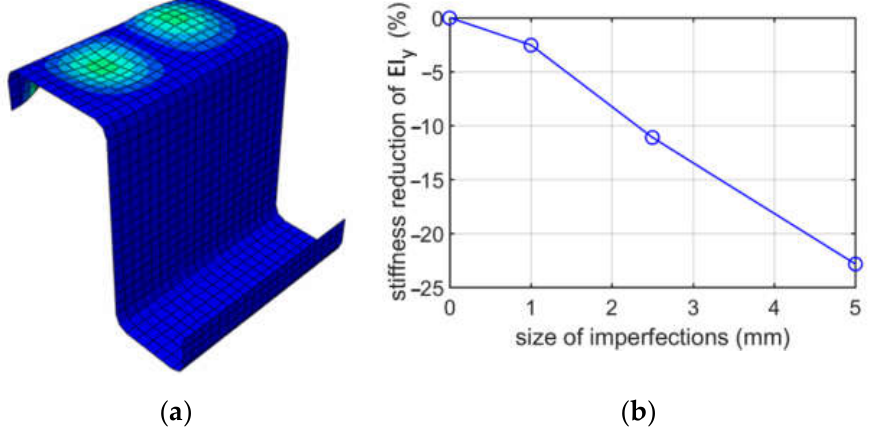
Figure 9. Buckling due to bending about the horizontal axis for (i) case, for a depth of 100 mm: ( a ) mode 1; ( b ) plot of the stiffness reduction of EI y , depending on the size of imperfections.